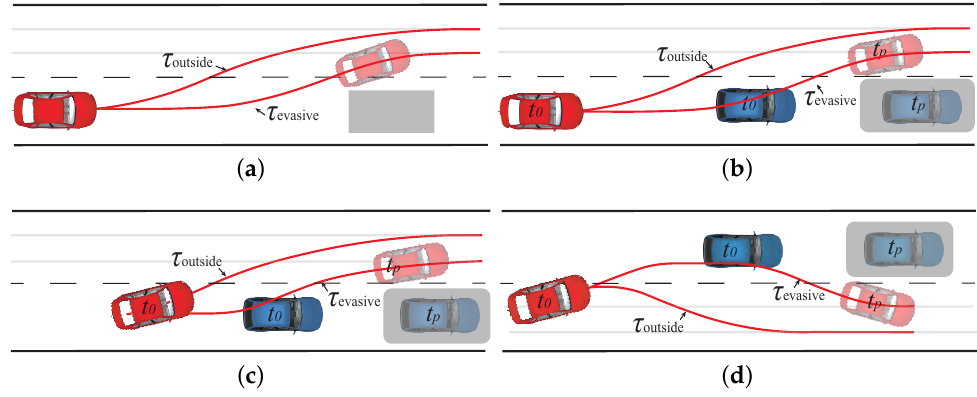
Figure 13. The driving envelope for lane-change and lane-change abortion. ( a ) The driving envelope for collision avoidance of static obstacle. ( b ) The driving envelope for lane-change before lateral movement. ( c ) The driving envelope for lane-change during lateral movement. ( d ) The driving envelope for lane-change